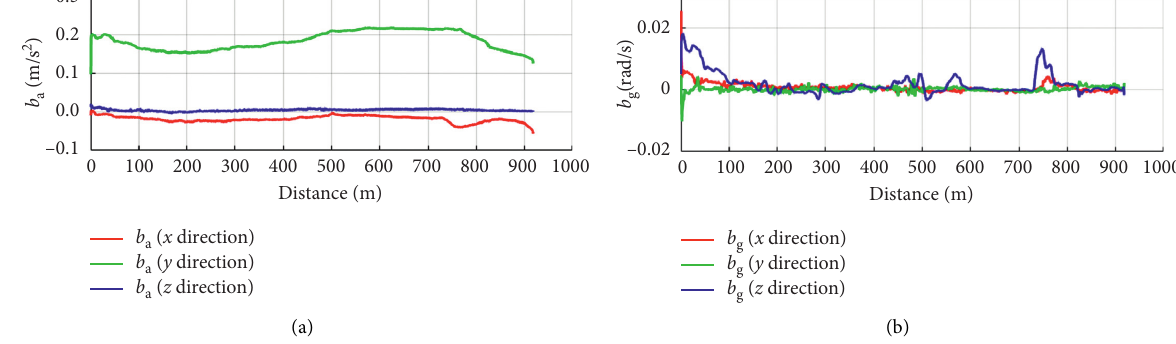
Figure 10: Iterated CKF estimation of accelerometer bias (a) and gyroscope bias (b) with dataset